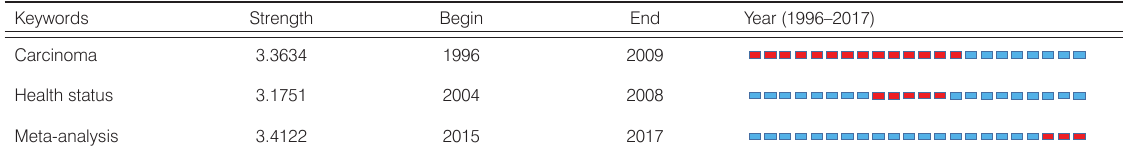
Table 3. Burst terms in research on self-management by patients with breast